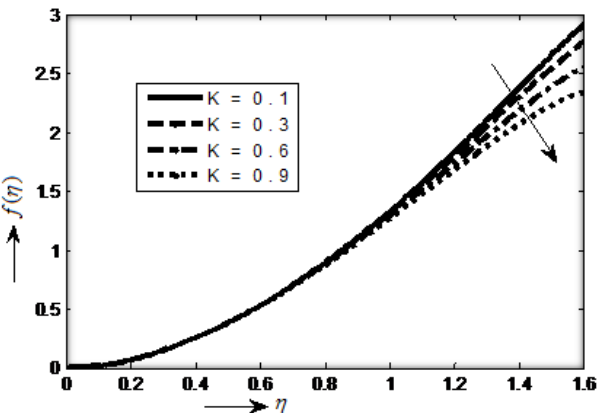
Figure 2. Variation of fluid velocity f (  ) against  for permeability parameters K (0.1, 0.3, 0.6, 0.9) by taking parameters M = 2, Re = 2.0 and  =0.5